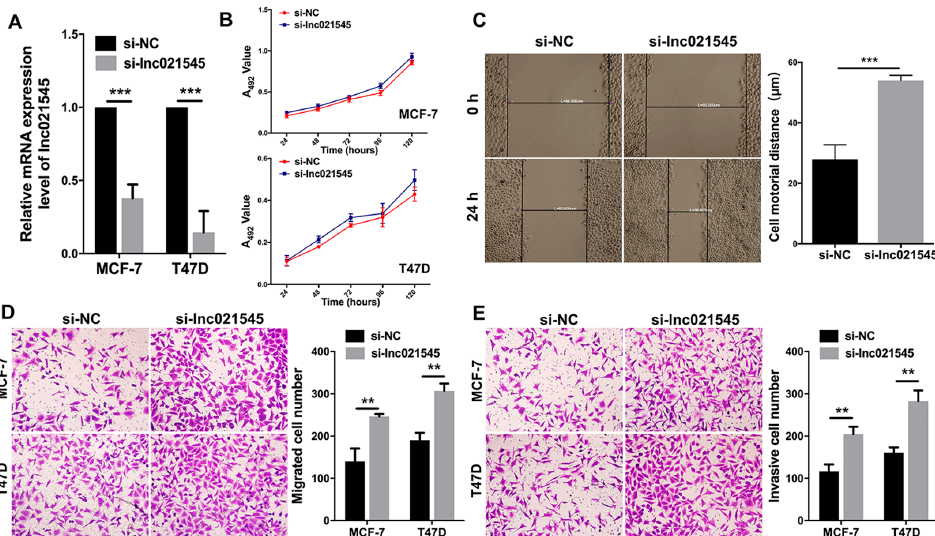
Figure 3. The influences of lnc021545 downregulations on the proliferation, motility, migration, and invasion of BC cells. ( A ) The downregulations of lnc021545 in MCF-7 and T47D cells were determined via qRT-PCR. ( B ) MTT assay was performed to measure the effect of lnc021545 knockdown on the proliferations of MCF-7 and T47D cells. ( C ) The effect of lnc021545 knockdown on the cell motility of MCF-7 cells was measured via wound healing assay. The transwell assays were performed for the cell ( D ) migration and ( E ) invasion. (** p < 0.01, *** p < 0.001, n = 3). MTT assay was measured the effect of lnc021545 on the proliferation of BC cells.